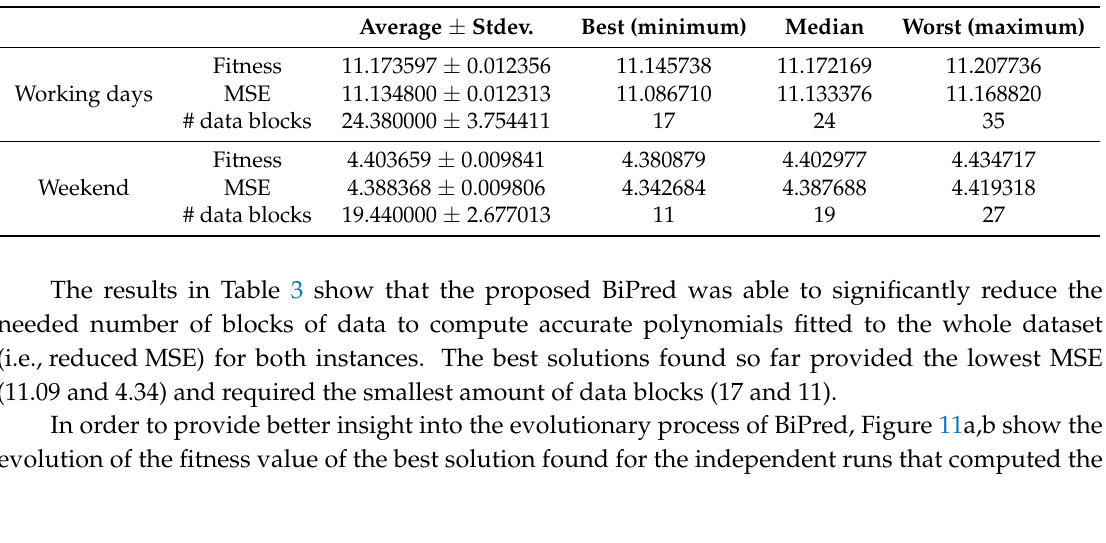
Table 3. Numerical results over 100 independent